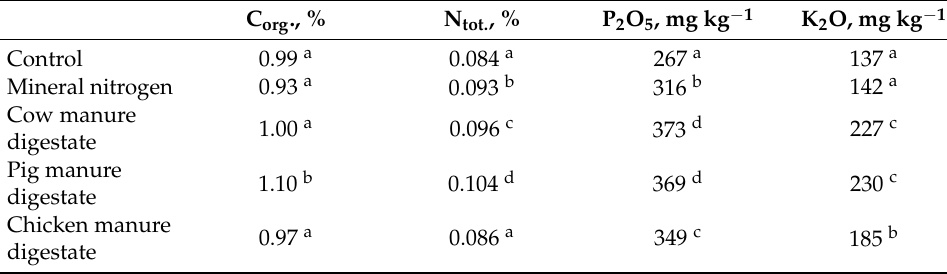
Table 4. Soil (loam) chemical composition after